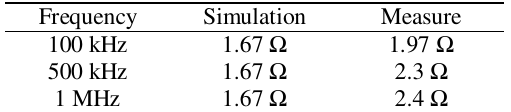
Table 2: Resistance the spiral inductor as a function of